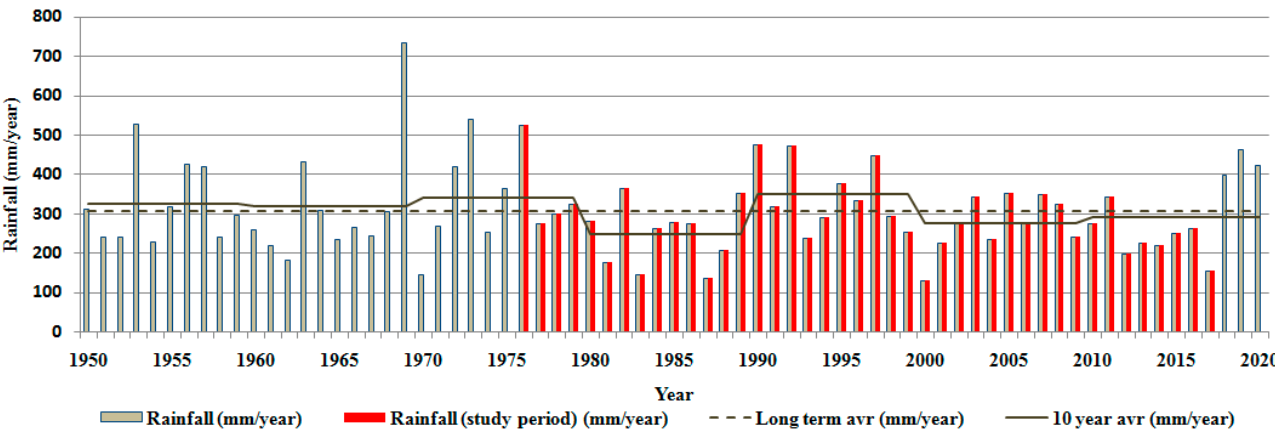
Figure 2. Average annual rainfall at Kairouan during 1950–2020 (Source: Tunisian Meteorological Institute).